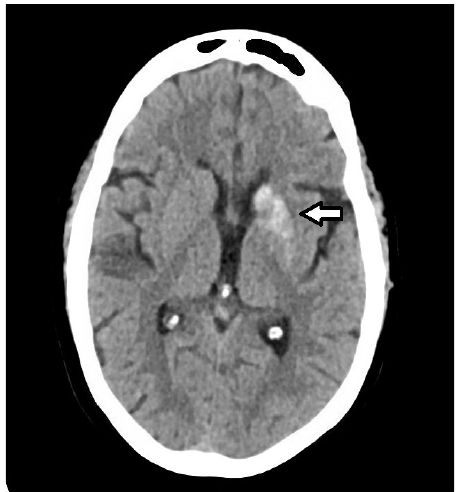
Image 1. Computed tomography head imaging, which shows hyperintensity (arrow) in left caudate nucleus concerning for potential hemorrhagic